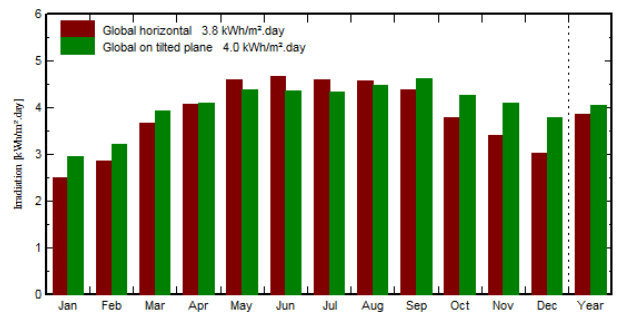
Figure 12. Global on tilted plane versus Global horizontal